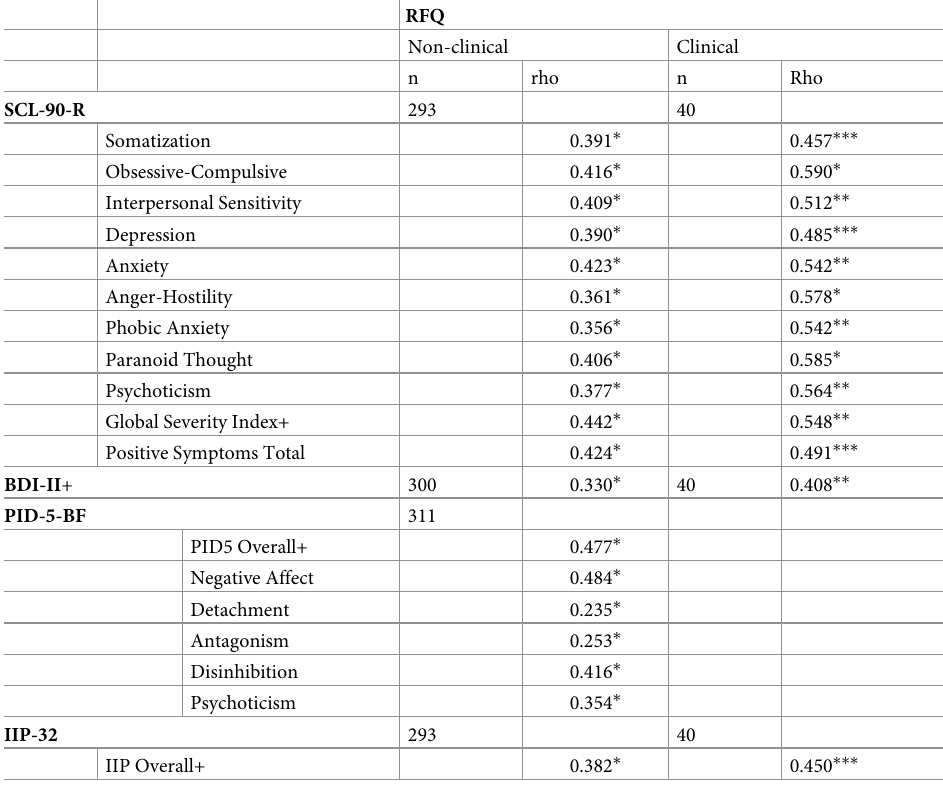
Table 4. Correlations between RFQ-8 and measures of psychopathology among non-clinical and clinical sample.